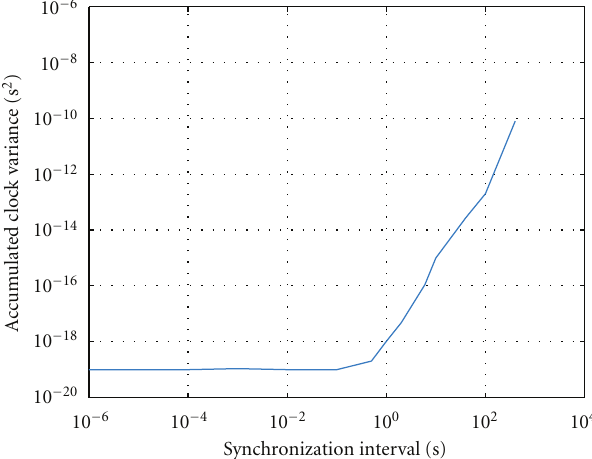
Figure 9: Typical Allan variance of an uncompensated crystal oscillator.